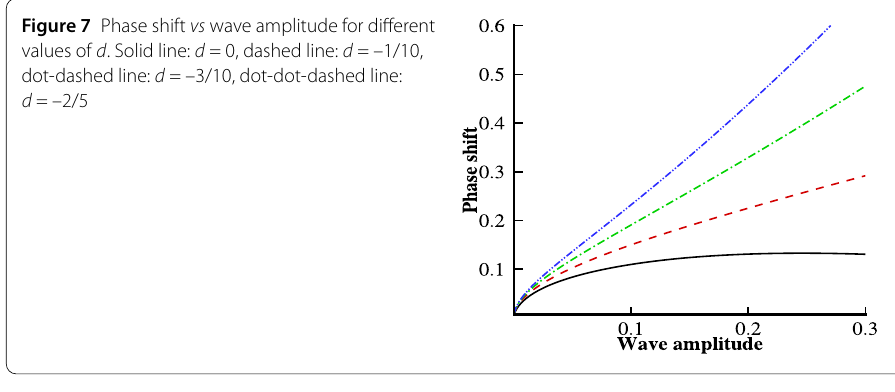
Figure 8 Phase shift vs wave amplitude for different values of τ . Solid line: τ = 0, dashed line: τ = 0.4, dot-dashed line: τ = 0.6, dot-dot-dashed line: τ =